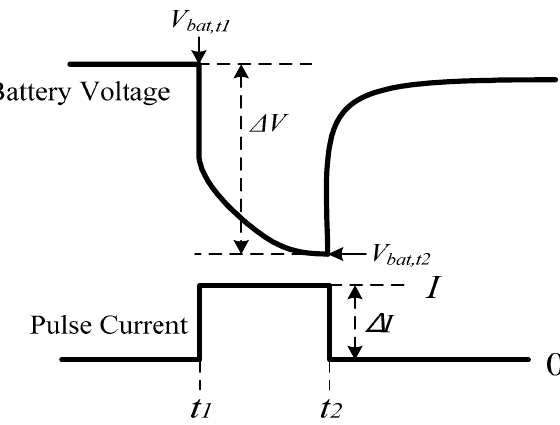
Figure 2. Battery voltage response during the pulse current.